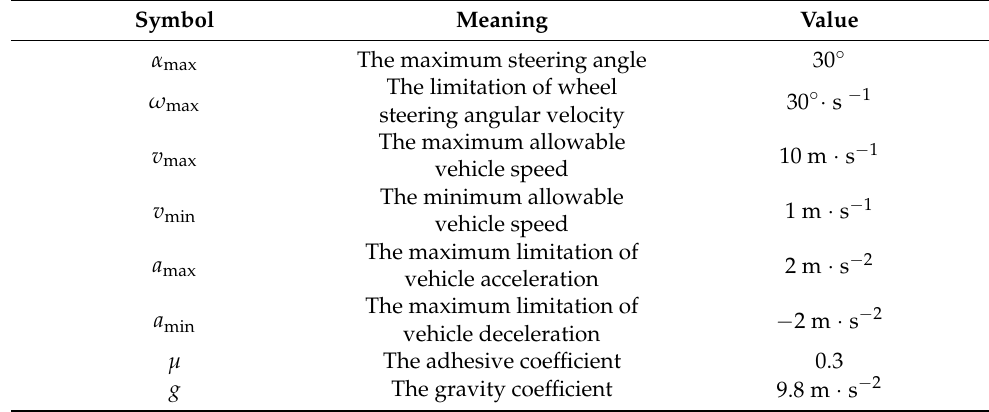
Table A3. Vehicle motion